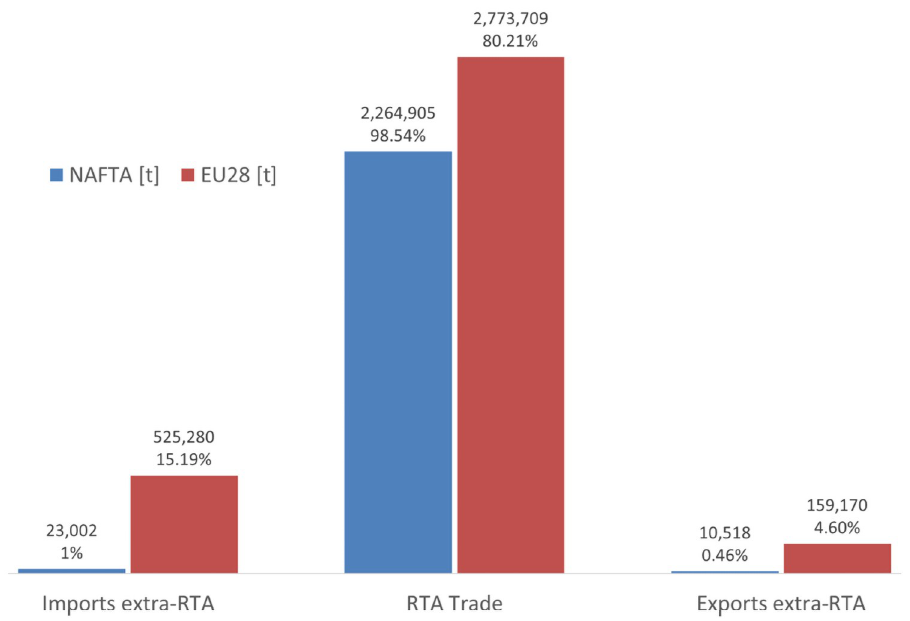
Fig 5. NAFTA and EU28 imports, exports and intratrade of tomatoes